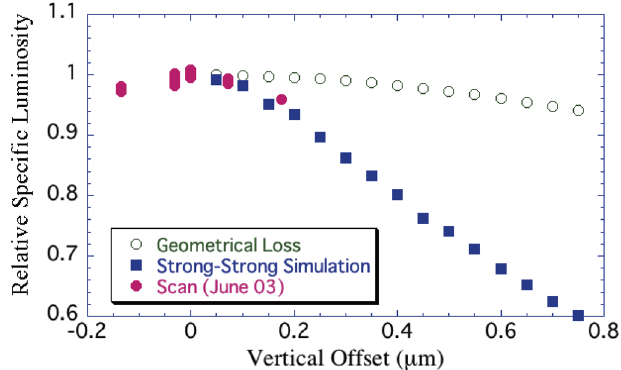
FIG. 5. (Color) Luminosity degradation due to the vertical off- set. Both an experimental result and a strong-strong simulation are shown. Also shown is a calculation of a geometrical loss.